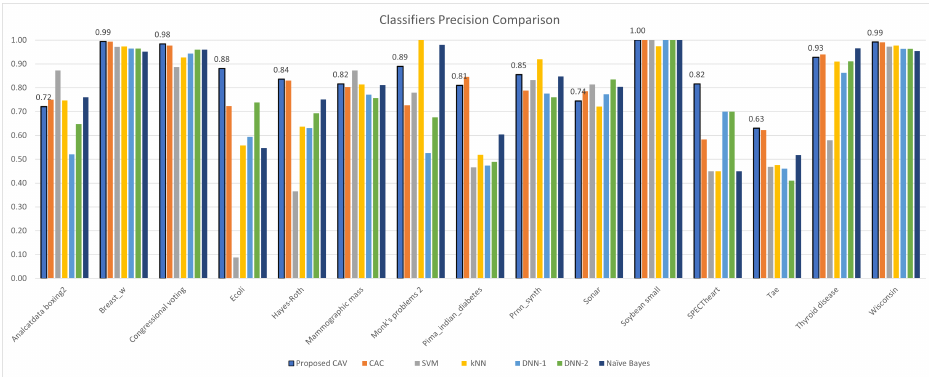
Figure 9. CAV with other classifiers; precision comparison for the test datasets.